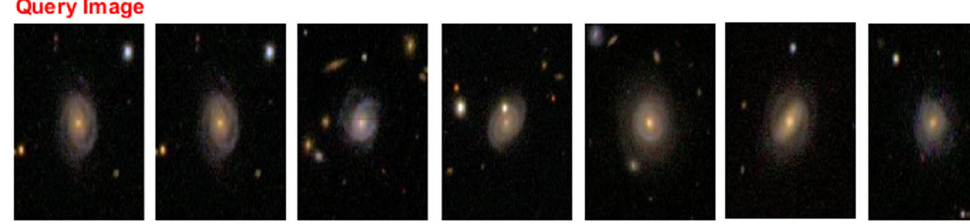
Figure 2. Galaxy image retrieval for a spiral galaxy 29 .